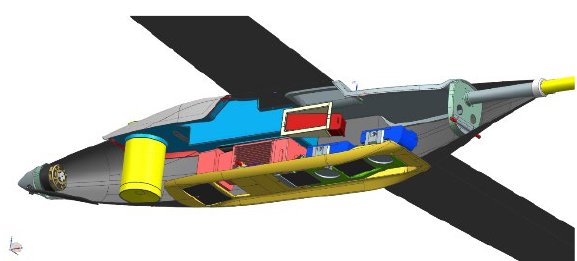
Figure 1. Location of the sensors and components in the platform body, in pink (light red) VUX mini-UAV1 scanner in dark blue two Sony Alpha 6000 cameras (Bakuła et al., 2018a)